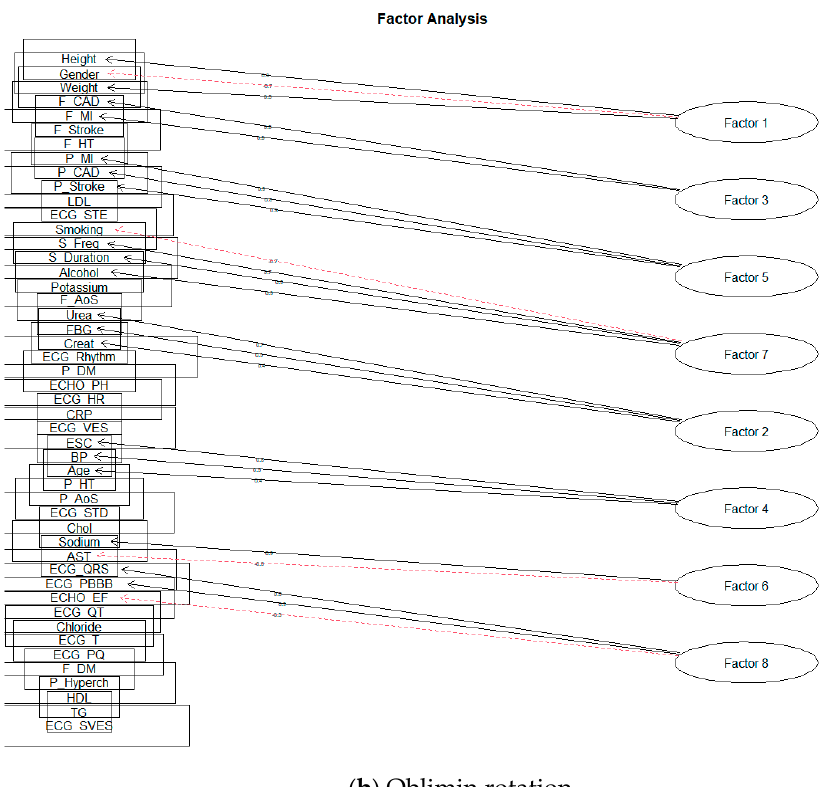
Figure 10. The eight-factor model of FA.